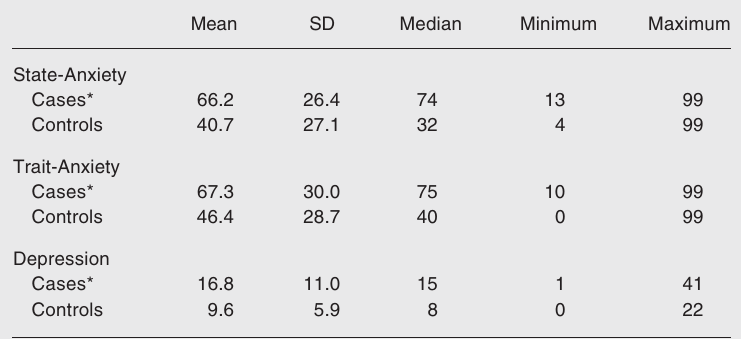
Table 1. State-Trait Anxiety Inventory and Beck Depression Inventory scores for patients with recurrent renal colic (N = 32) and control subjects (N = 32). Mean SD Median Minimum